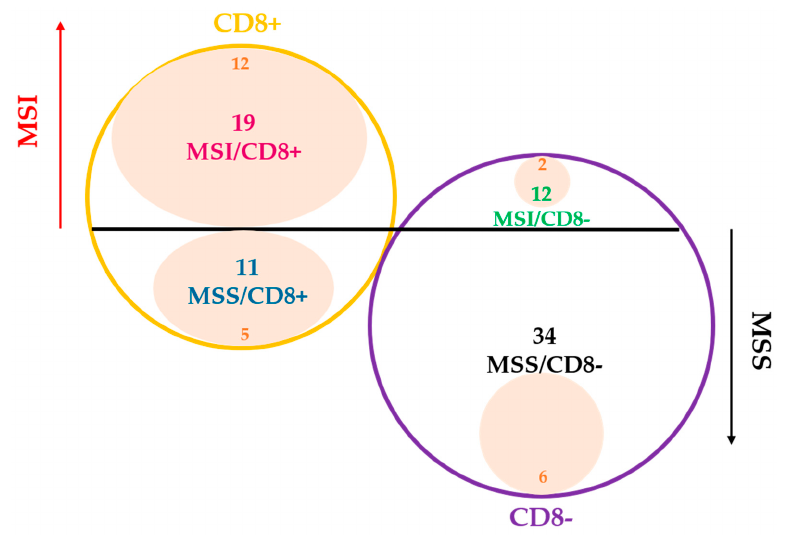
Figure 6. Graphic distribution of TIS high CRCs (pink areas, TIS > 7.274) among metastatic CRCs (n = 76) considering both MSI status (MSI red arrow vs. MSS black arrow) and CD8 TIL content (CD8+ yellow circle vs. CD8 − purple circle).